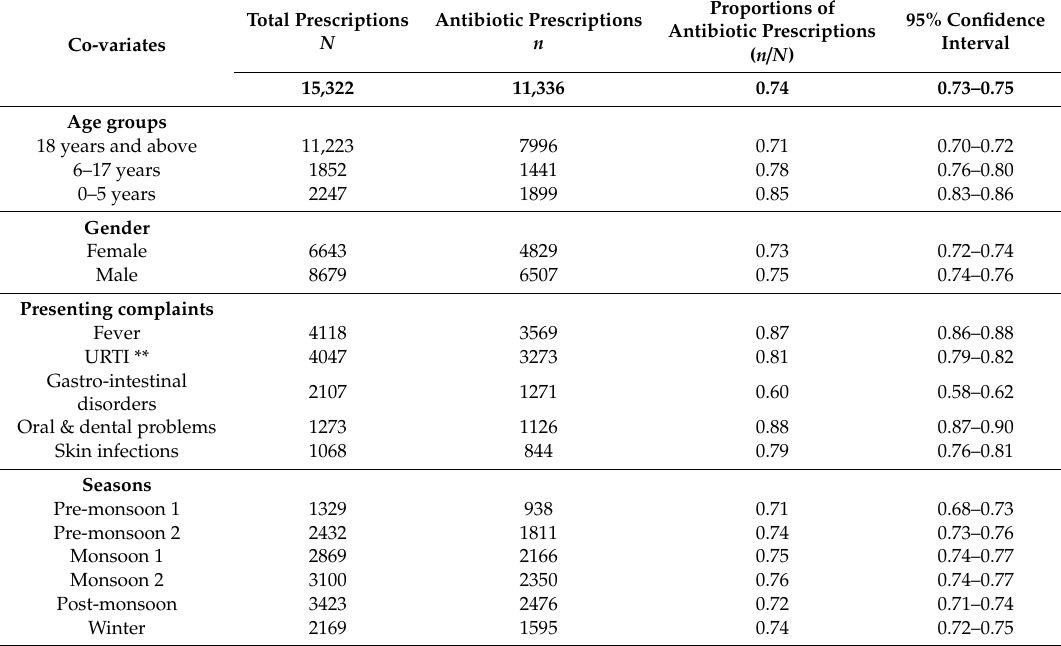
Table 1. Incidence of antibiotic prescribing amongst the prescriptions collected from informal healthcare providers in rural Ujjain.